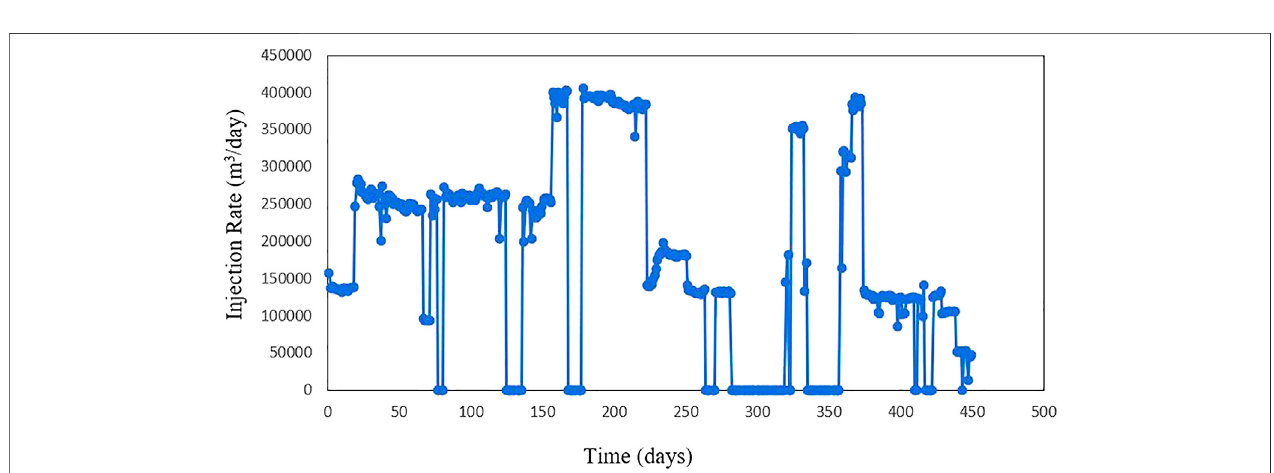
FIGURE 10 | Cran fi eld CO 2 injection schedule used for simulation at injection well